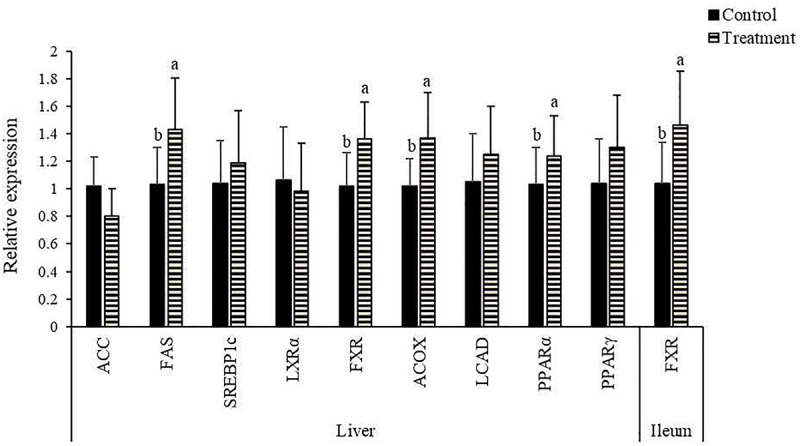
Effects of Clostridium butyricum treatment on the relative mRNA expression of lipid metabolism-related genes1 in the liver and ileum of laying hens. a,bTreatments with unlike letters were significantly different (P < 0.05). 1ACC, acetyl-CoA carboxylase; FAS, fatty acid synthetase; SREBP, sterol-regulatory element-binding protein; LXR, liver X receptor; FXR, farnesoid X receptor; ACOX, acyl-CoA oxidase; LCAD, long-chain acyl-CoA dehydrogenase; PPAR, peroxisome proliferator activated receptor.